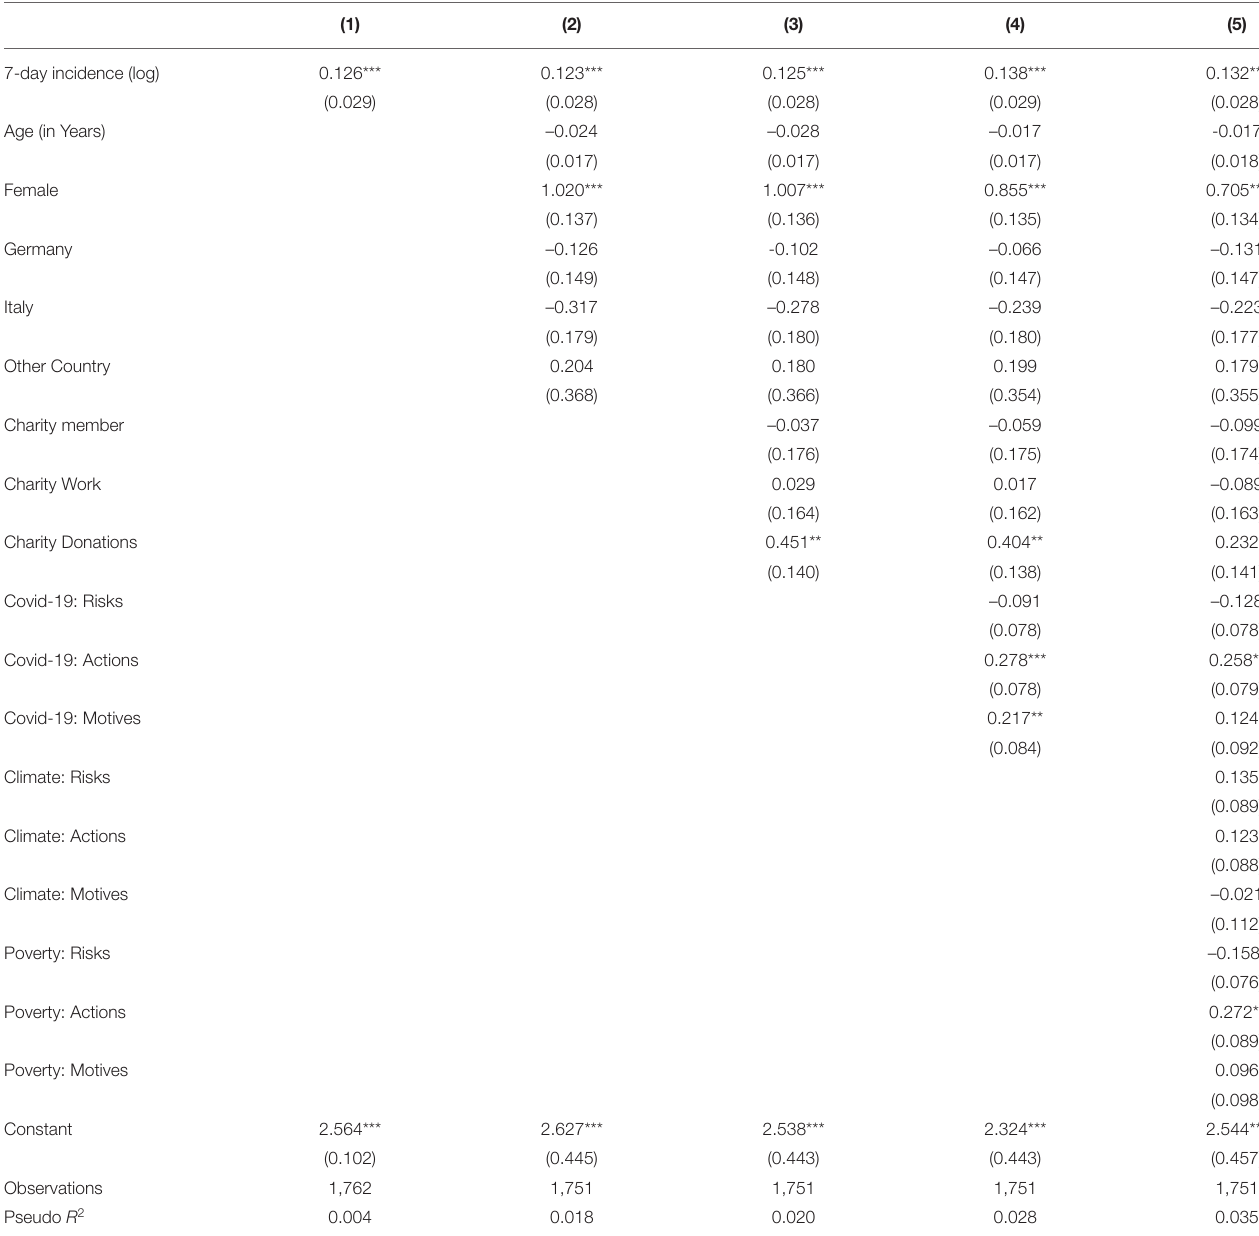
TABLE 2 | Regression analyses of total donations (pooled across all charities and all treatments) on 7-day incidence rates and individual-level